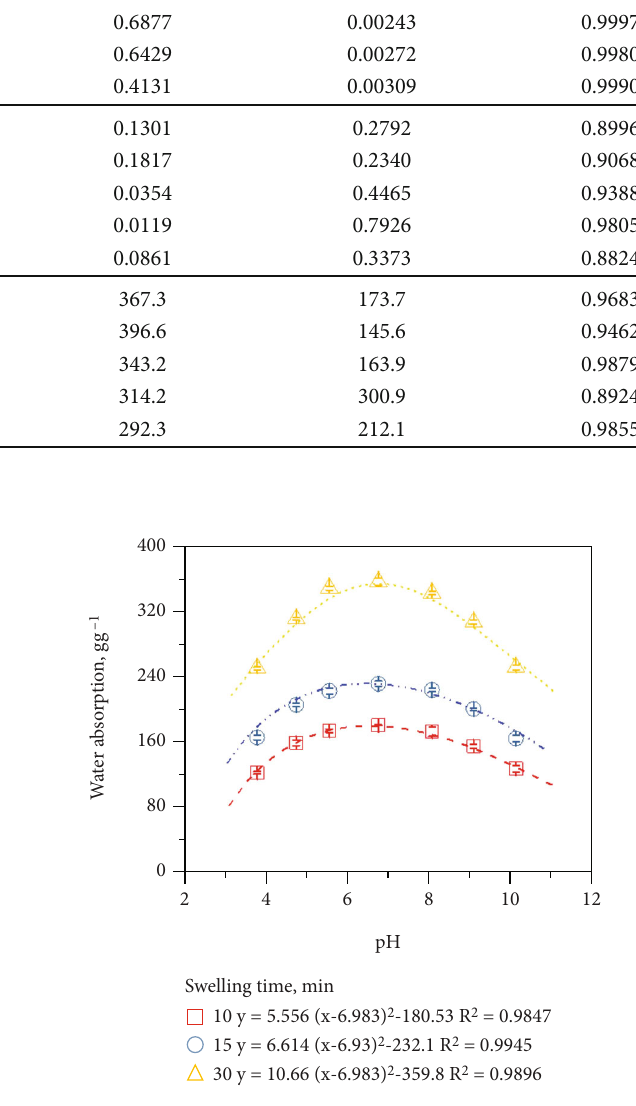
Figure 2: E ff ect of pH on the acrylic SAPs ’ swelling (sample